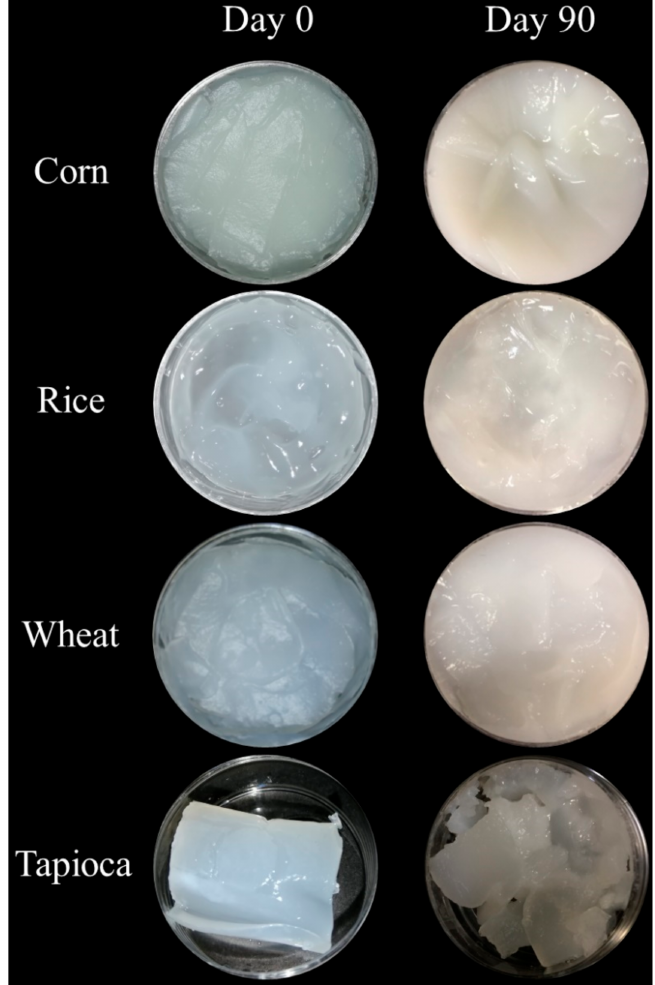
Figure 4. Influence of storage time on the physical appearance of starch-based HPP